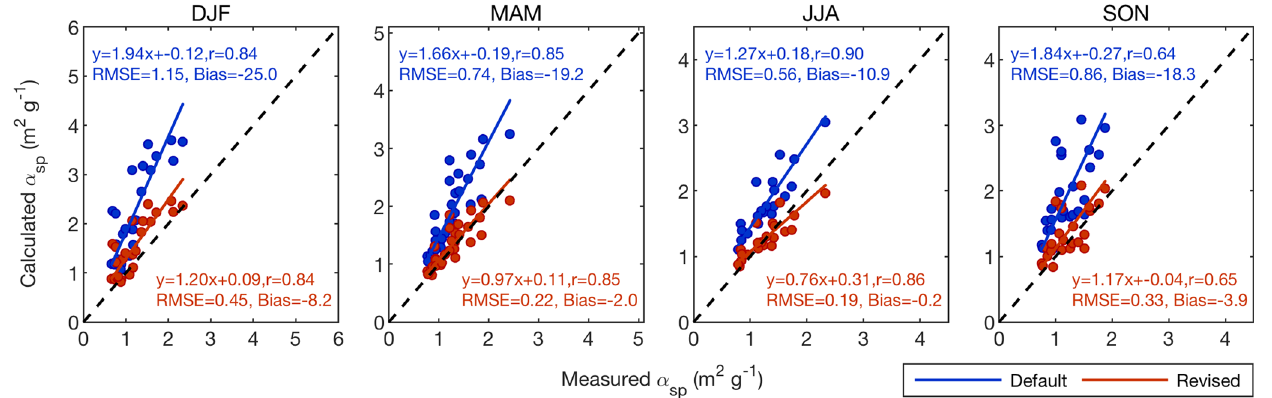
Figure 6. Average measured vs. calculated α sp (550nm) at IMPROVE sites between 2000 and 2010 using GEOS-Chem default and revised optical tables for measurements taken in dry conditions (RH < 35%) in winter, spring, summer, and fall. The 1 : 1 line is black. Slope, offset, and correlation coefficient are